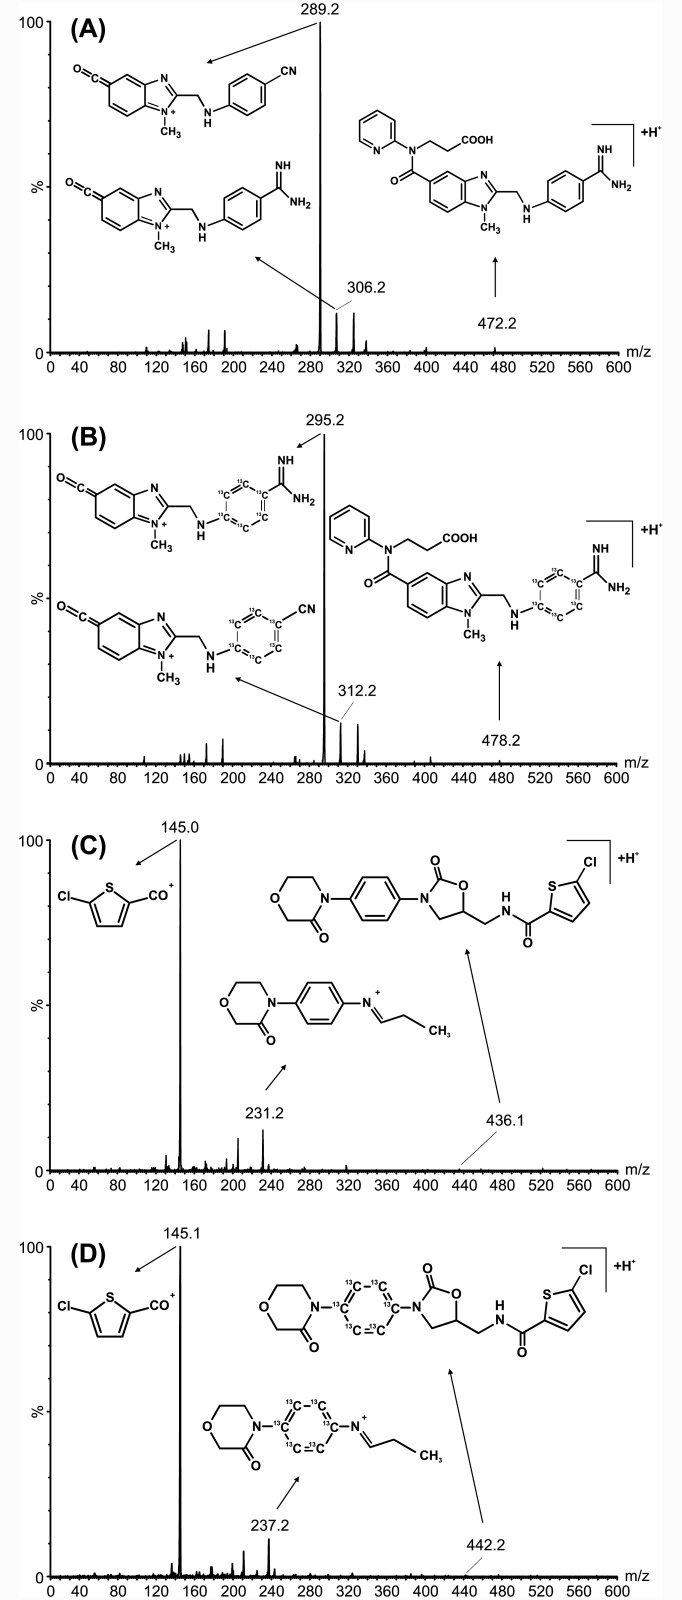
Product ion spectra of DOACs.Product ion spectra of dabigatran (A) and rivaroxaban (C), as well as its internal standards [13C6]-dabigatran (B) and [13C6]-rivaroxaban (D) are depicted. The MH+ precursor ions and the fragment ions are shown. The chemical structures of the molecules are depicted. In addition, the positions of the 13C6 atoms of the internal standards [13C6]-dabigatran (B) and [13C6]-rivaroxaban (D) are shown.